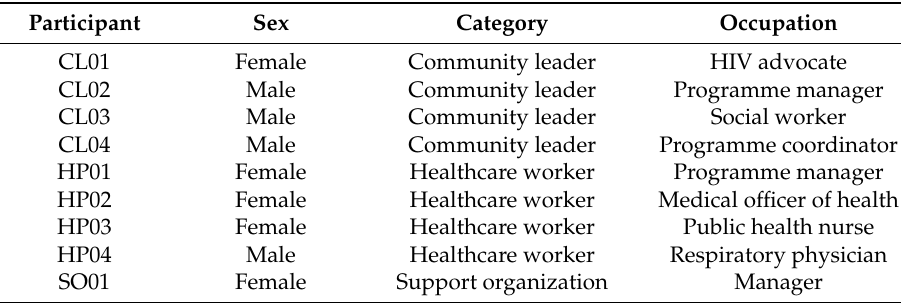
Table 1. Participant Demographic